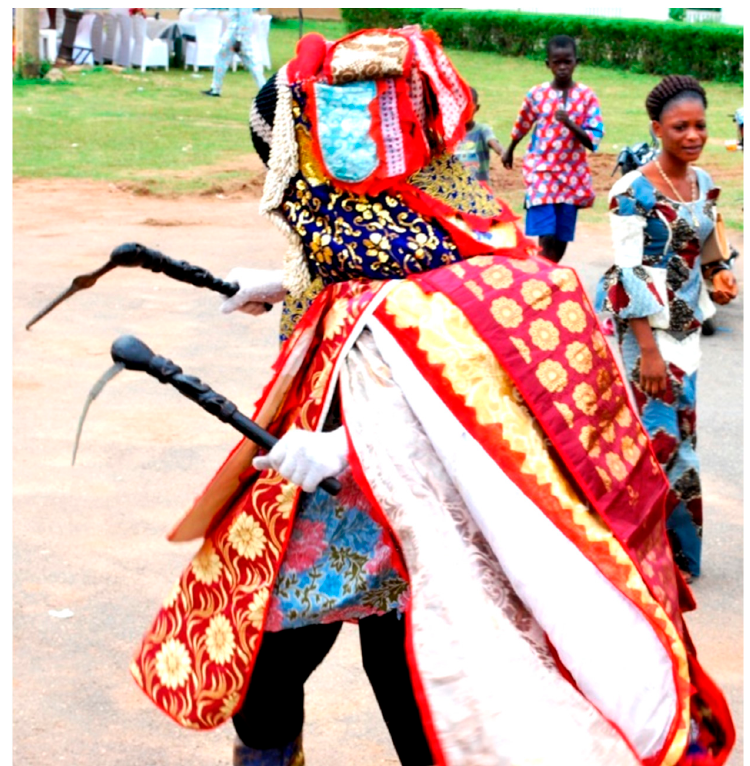
Figure 5. Egúngún Mowuru holding Kònkòsò in its left and right hands. Source: Photograph by author.